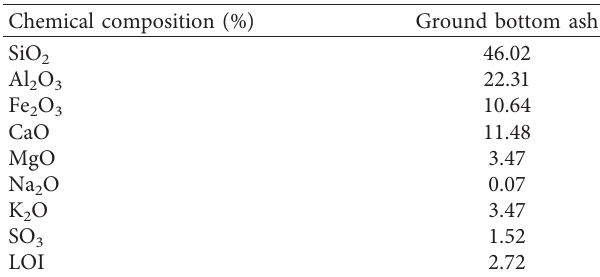
Table 1: Chemical composition of ground bottom ash. Chemical composition